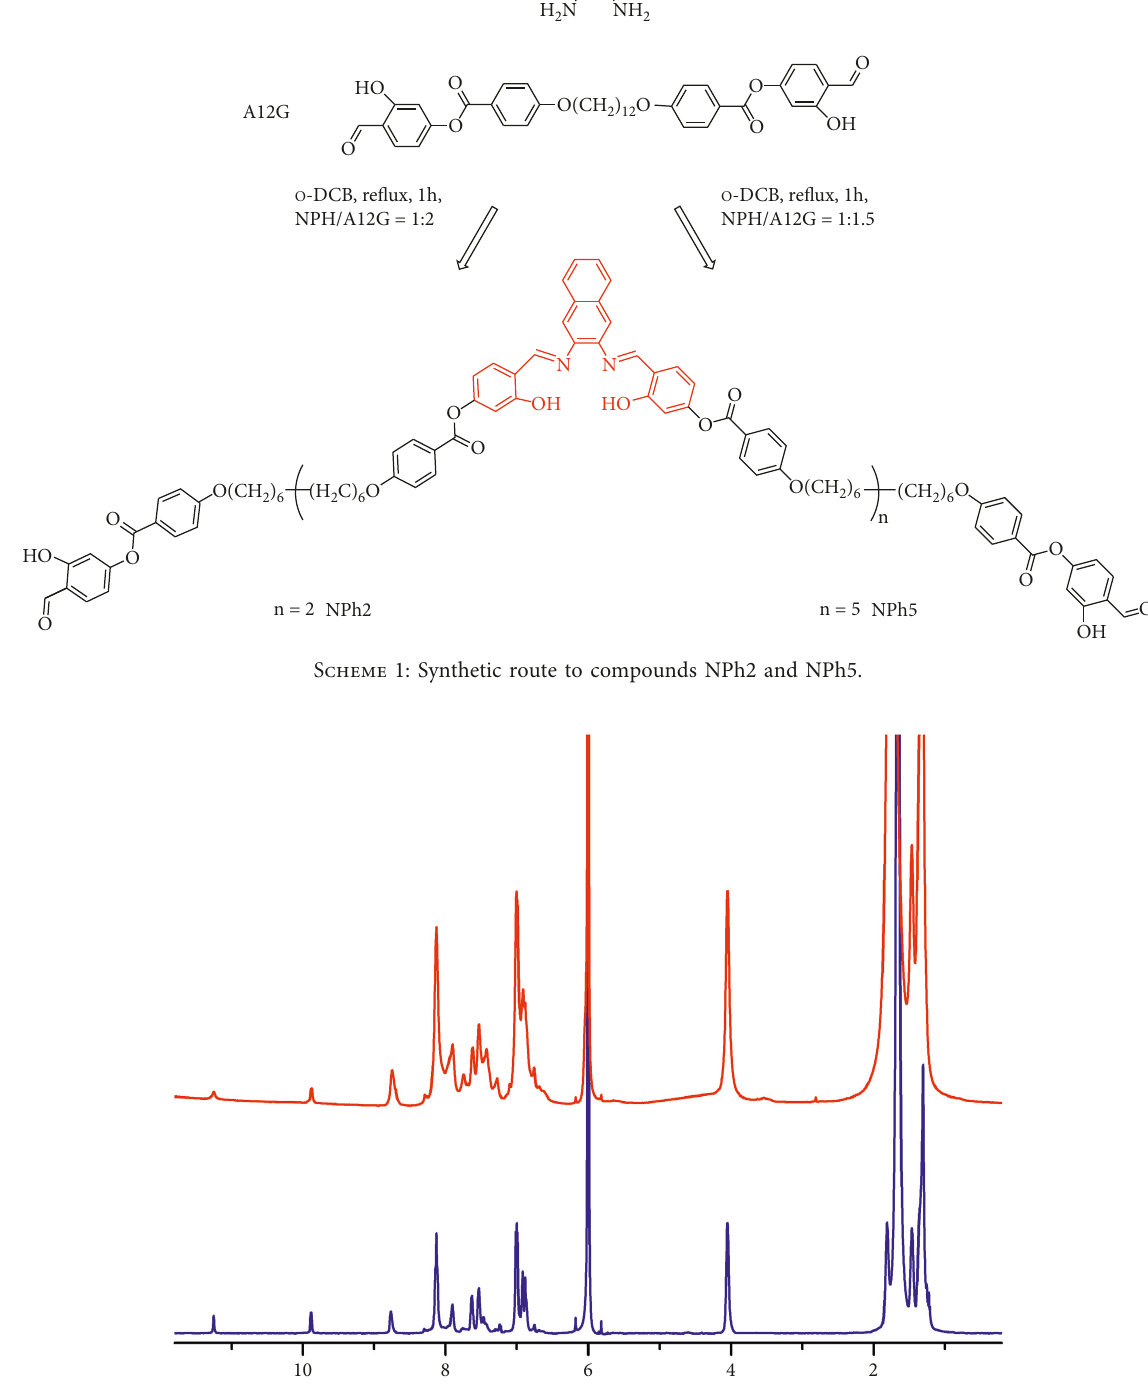
Figure 1: 1 H NMR spectra (ppm) of NPh2 (blue curve) and NPh5 (red curve) in 1,1,2,2-tetrachloroethane